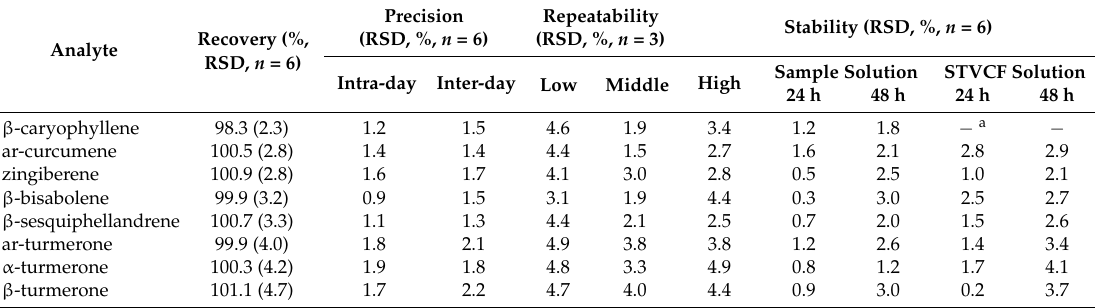
Table 4. Result of accuracy, precision, repeatability and